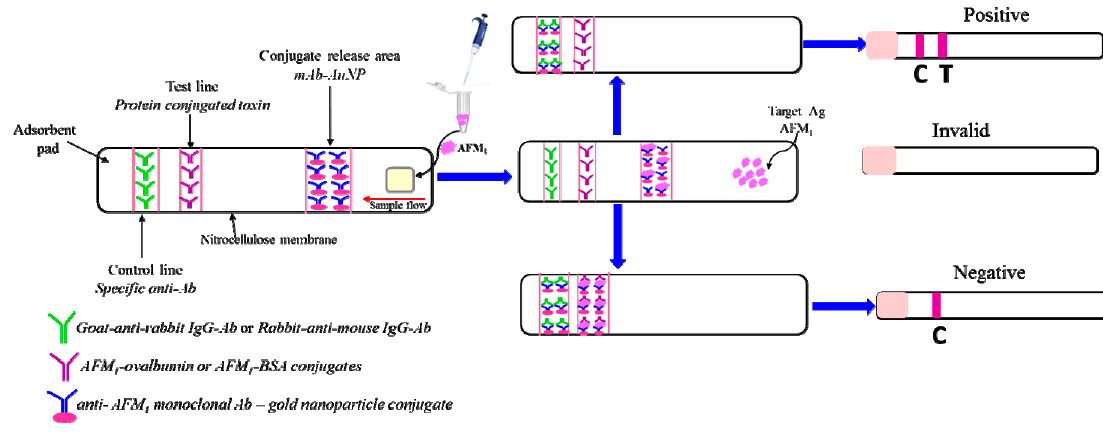
Figure 3. Detection of aflatoxin M 1 (AFM 1 ) using immunostrip.